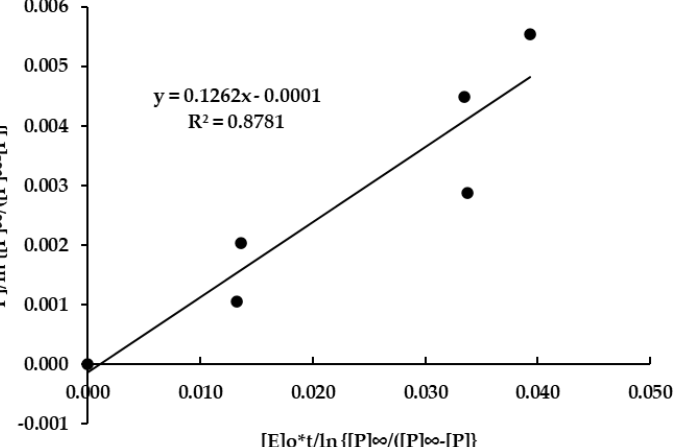
Figure 2. The relationship between [P]/ ln{[P]∞/([P]∞− [P]} and [E]0.t/ ln{[P]∞/([P]∞− [P]} at an enzyme concentration of 10%.